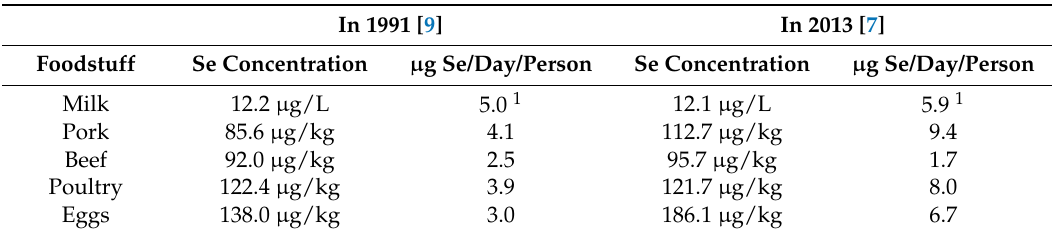
Table 3. Comparison of Serbian selenium intake by animal foodstuffs in 1991 and 2013. In 1991 [9] In 2013